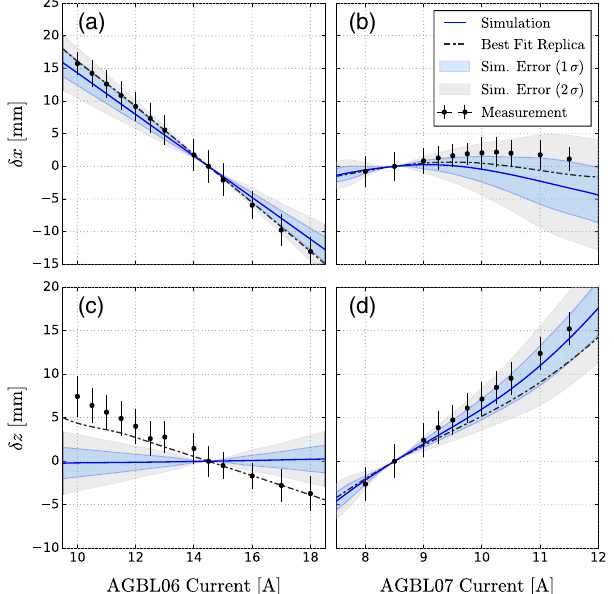
FIG. 12. Antiproton beam position at the LDS as a function of the AGBL06 [panels (a) and (c)] and AGBL07 [panels (b) and (d)] interconnect magnet currents. The beam position has been separated into components along the x and z axes of Fig. 7(a). The experimental data were collected while the ALPHA-g external solenoid was not energized. An equivalent, simulated steering curve for each dataset is shown as a solid red line. The shaded intervals indicate the uncertainty in the simulated beam position due to mechanical errors along the full ¯ p beamline.